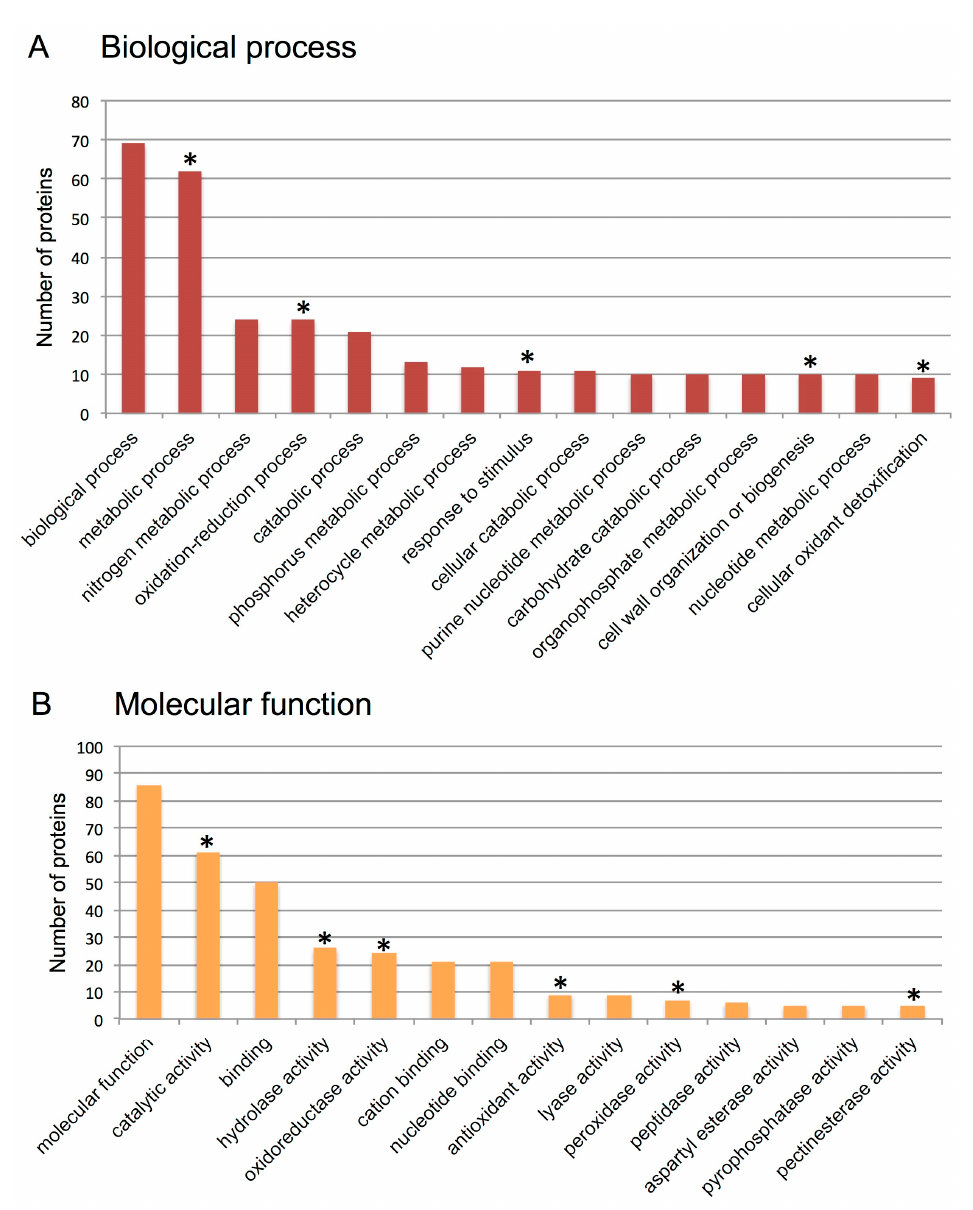
Figure 4. Analysis of proteins released from pericarps of S. alba (proteome analysis). Gene Ontology (GO) categorization for biological process ( A ) and molecular function ( B ). Asterisks indicate overrepresented protein groups in the pericarp samples. Note, the first column in A and B indicates the number of proteins identified for the examined categorization. Also, other columns do not add up to the first one because a given protein can fit multiple